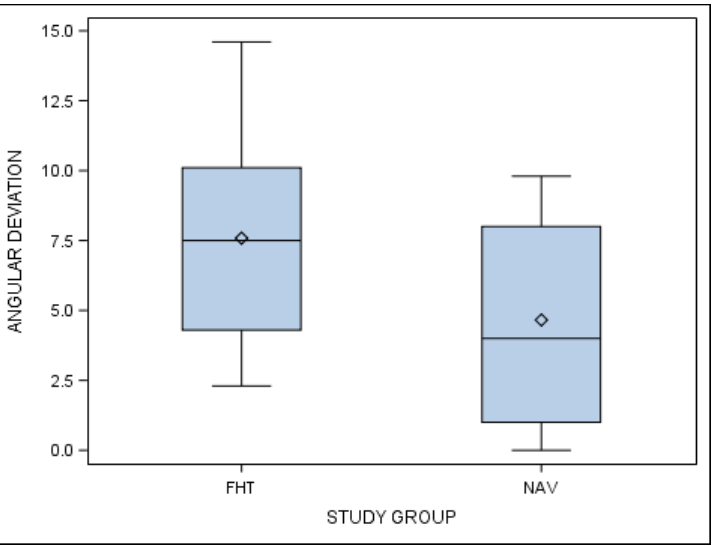
Figure 10. Box plot of angular deviations in planned and performed orthodontic micro-screws between the computer-aided static navigation technique and conventional freehand technique study groups.